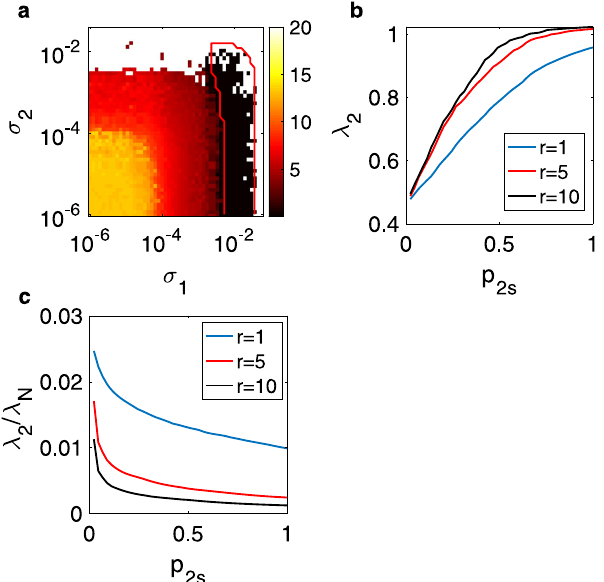
; x Þ ¼ ½ z 2 z ; 0 ; 0 (cid:3) T , d h ð 1 Þ ð x j k k j ; x Þ ¼ ½ 0 ; z 2 z ; 0 (cid:3) T , g h ð 1 Þ ð x j k k j